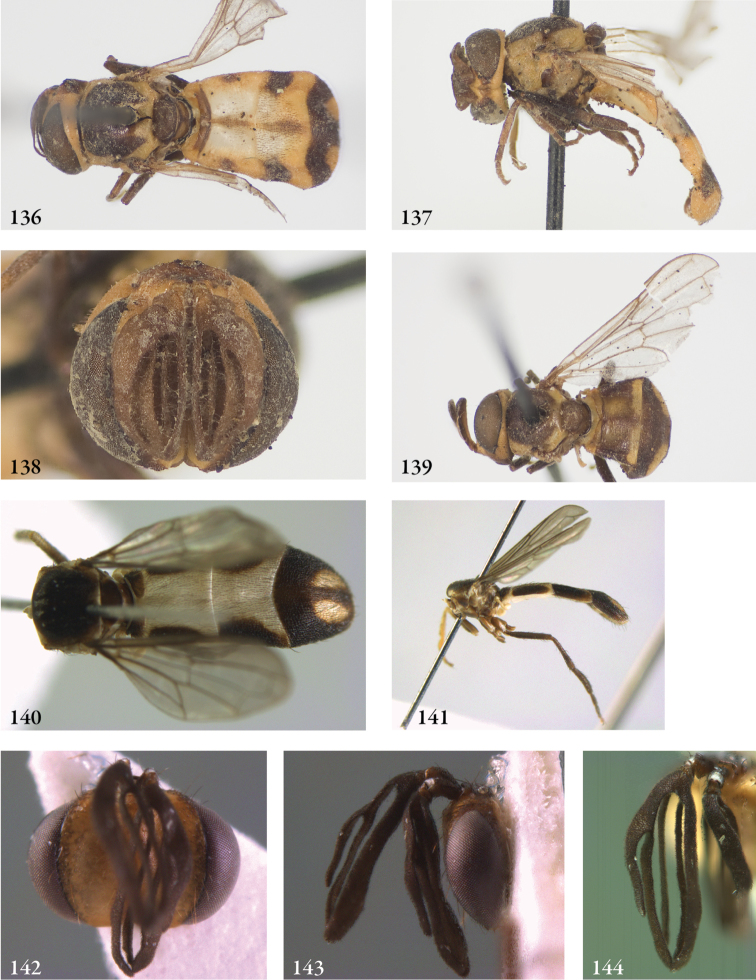
136–138
Masarygus planifrons male (syntype): 136 habitus dorsal 137 habitus lateral 138 head frontal 139
Masarygus planifrons female (syntype), habitus dorsal 140–143
Masarygus palmipalpus male (holotype): 140 habitus dorsal 141 habitus lateral 142 head frontal 143 head lateral 144 antenna.